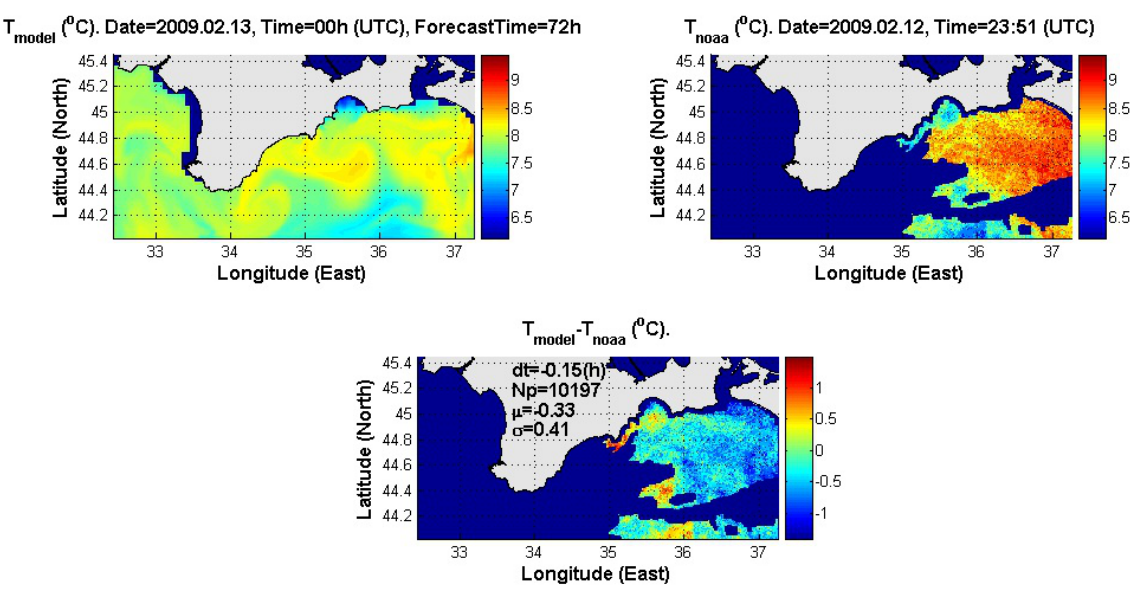
Fig. 14. Model forecast of SST for 72h (upper left), NOAA AVHRR SST observations (upper right) and difference between simulated and observed fields (bottom) maps (dark blue – cloud occupied areas). Some statistic is shown on the third panel.